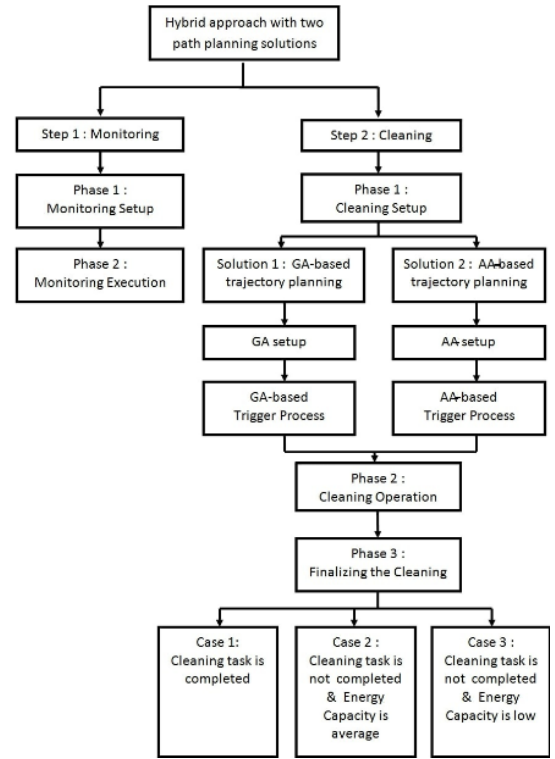
Figure 2: Structure of the proposed hybrid approach.